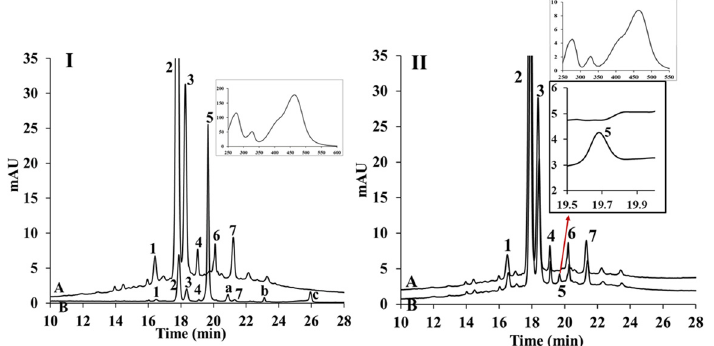
Figure 3. Chromatogram of strawberry juice extract; ( I ) describes uptake experiment (A) prior to cell uptake experiment, (B) extracted from cells following the uptake experiment. ( II ) describes the change of strawberry extract during 1 h incubation in the absence of the Caco-2 cells, (A) chromatogram of initial strawberry extract at t = 0 h; (B) chromatogram after 1 h incubation: 1 = cyanidin-3-glucoside; 2 = pelargonidin-3-glucoside; 3 = pelargonidin-3-rhamnosylglucoside; 4, 6, 7 = unknown compounds; Peaks 5, a, b, c =compounds appeared following uptake experiments. Inset is UV-visible spectrum of peak 5, λ max .= 275, 325 and 465 nm.